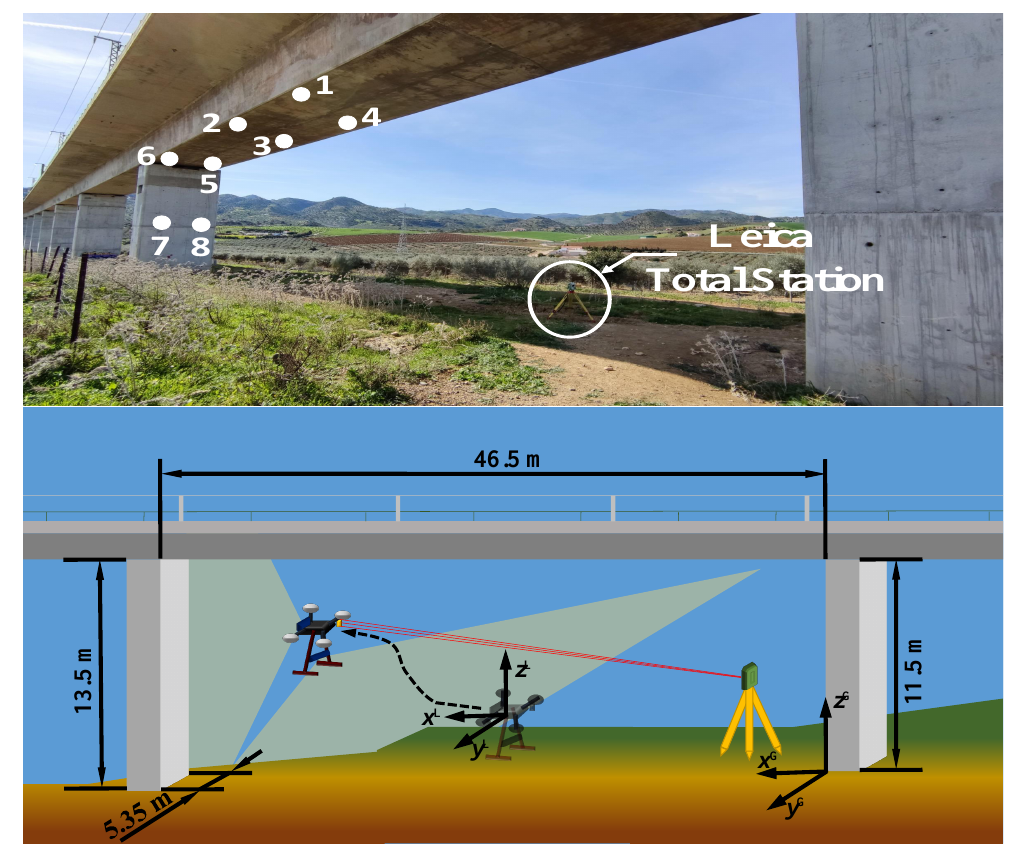
Figure 5. Top: a picture of the viaduct scenario, where the position of the total station and the inspection points are indicated. Bottom: a scheme with measurements of the scenario, the global reference frame, and the camera local reference frame. The red line represents the total station laser beam and the light-green regions the FOV of the